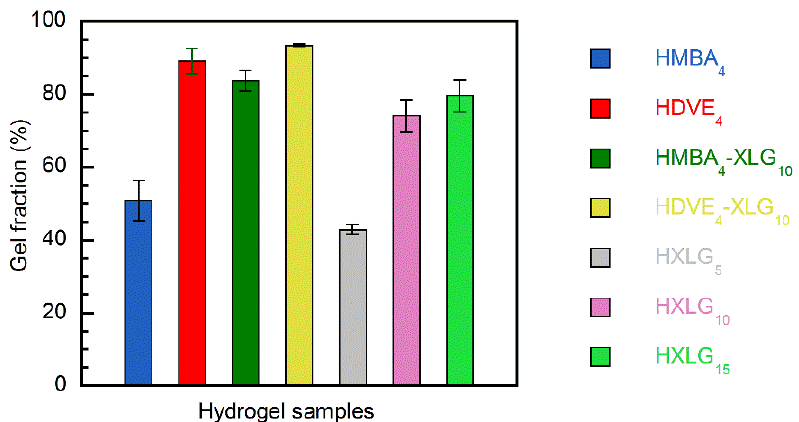
Figure 1. Gel fractions of the hydrogel samples synthesized.